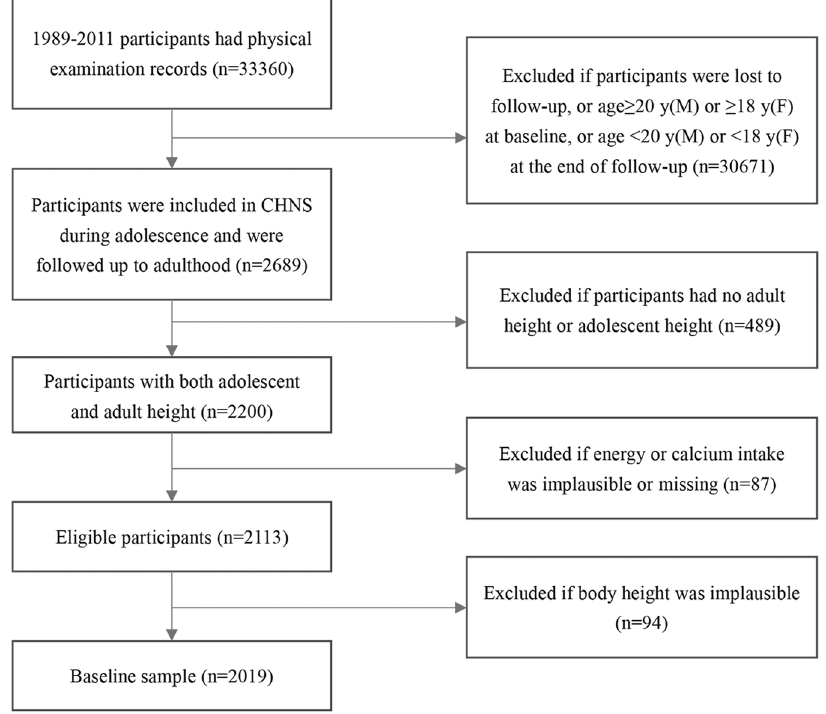
Figure 1. The flow chart of sample selection in the China Health and Nutrition